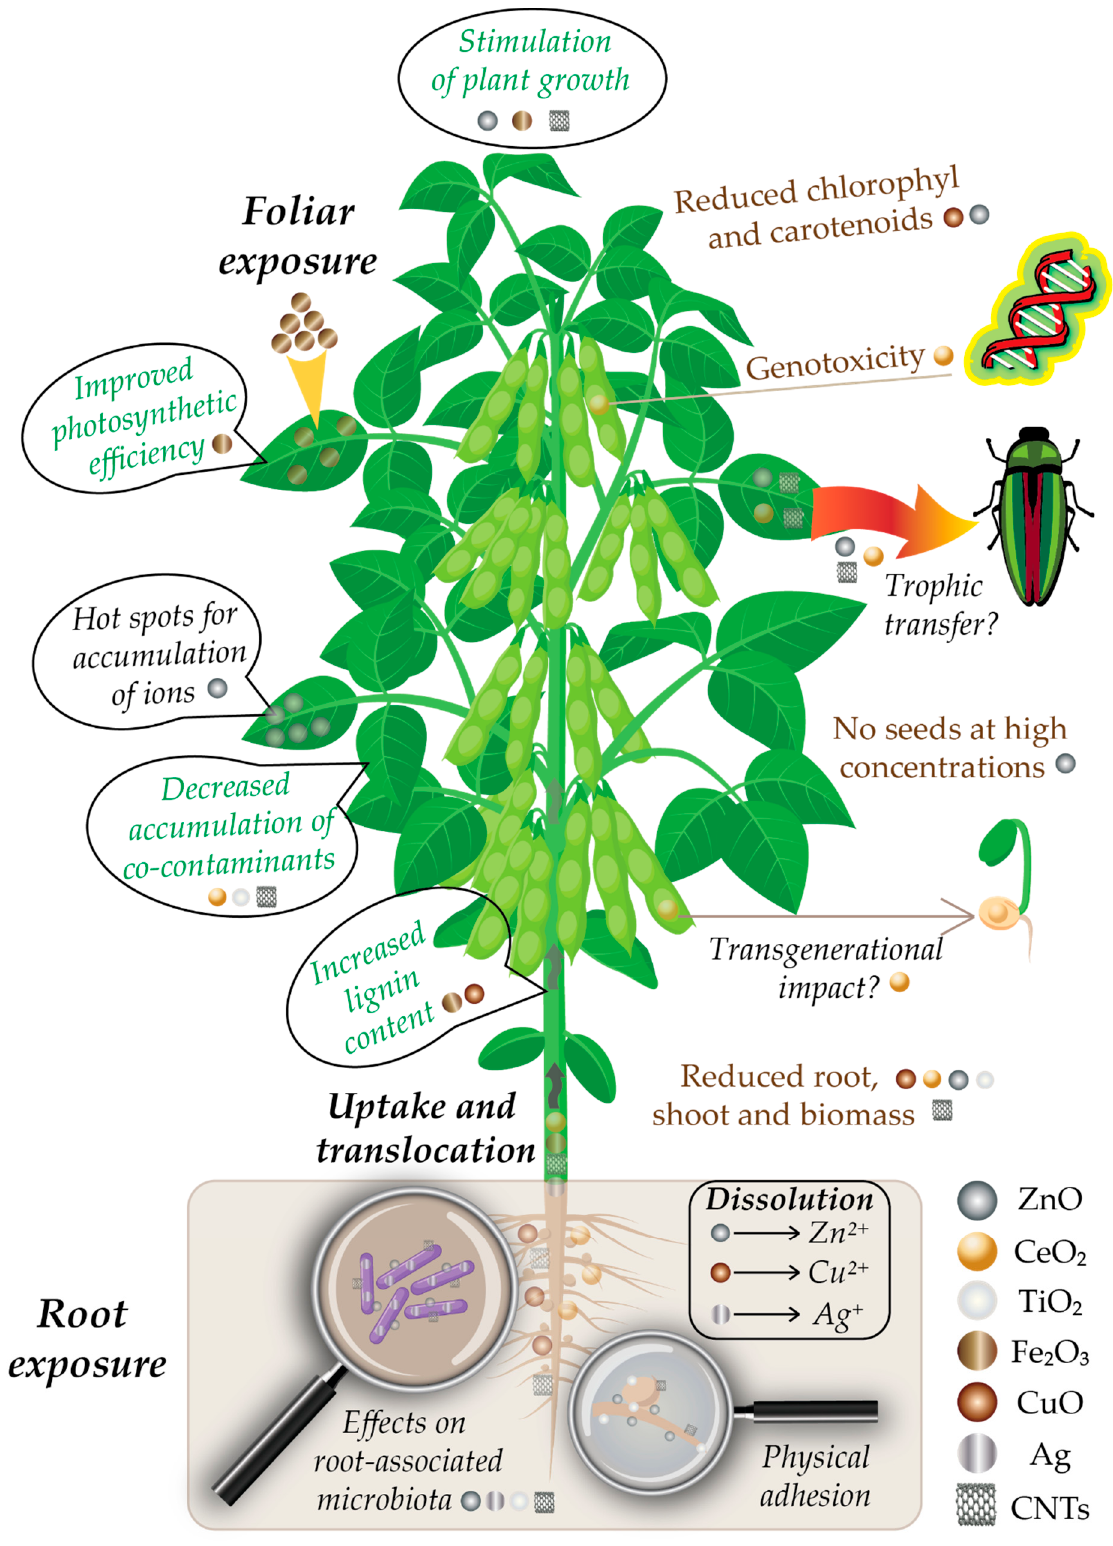
Figure 1. Schematic representation of engineered nanomaterials (ENMs) effects on soybean plants. Positive effects are depicted in green, negative ones in brown, and future research needs are followed by question marks.